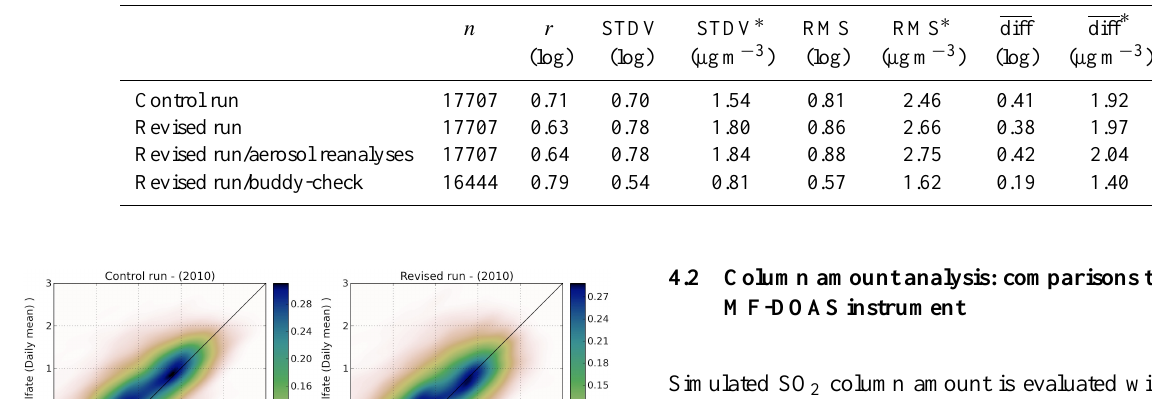
Table 3. Summary of sulfate comparison results.